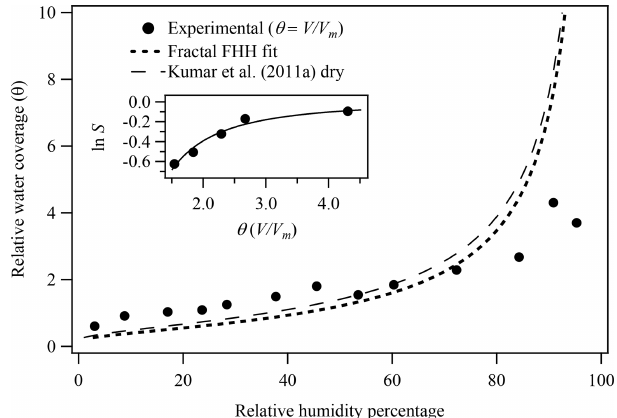
Figure 4. Illite experimental water adsorption isotherm (Hatch et al., 2012) and associated fractal FHH isotherm, where the exper- imental θ was calculated as V/V m and V m was determined from BET analysis of adsorption isotherm. FHH adsorption isotherms from FHH parameters determined from size-selected CCN mea- surements of dry-generated illite clay are also shown (Kumar et al., 2011a). The inset shows the constrained fractal FHH isotherm fit to the experimental water adsorption